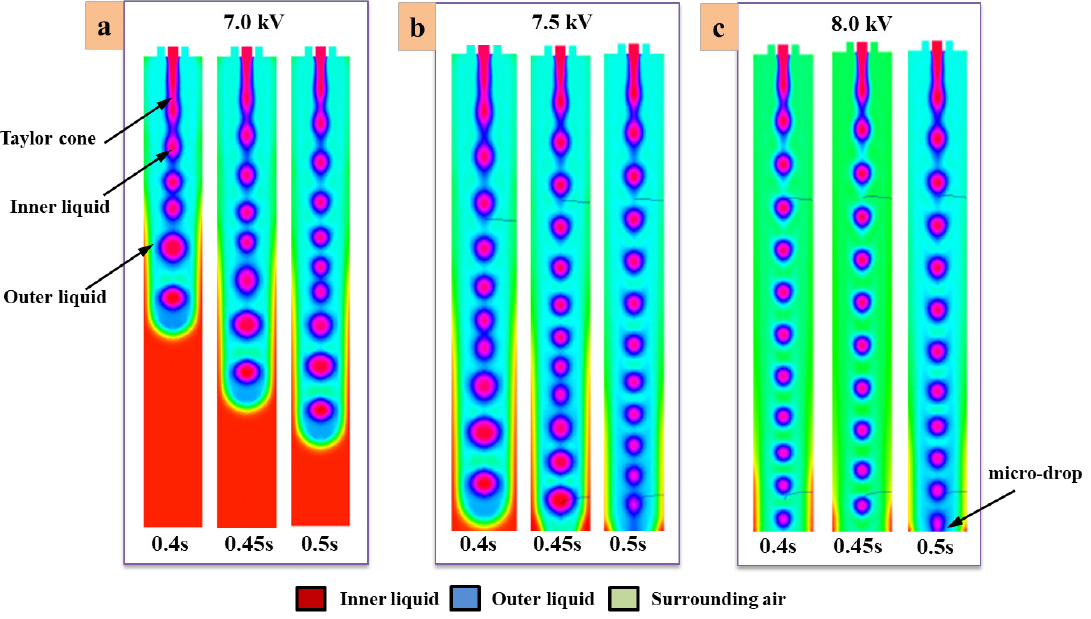
Figure 6. The formation of compound microdroplets during stable micro-dripping mode at different time intervals under various nozzle pulse voltages: ( a ) 7.0 kV , ( b ) 7.5 kV , and ( c ) 8.0 kV .